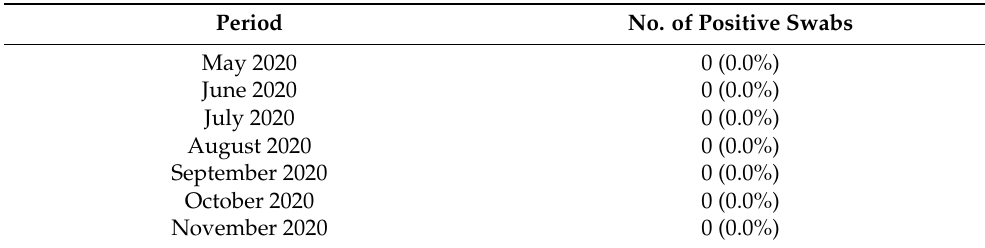
Table 4. Monitoring of 60 healthcare workers using SARS-CoV-2 nasopharyngeal swab performed every 5 days from May to November 2020: monthly report.